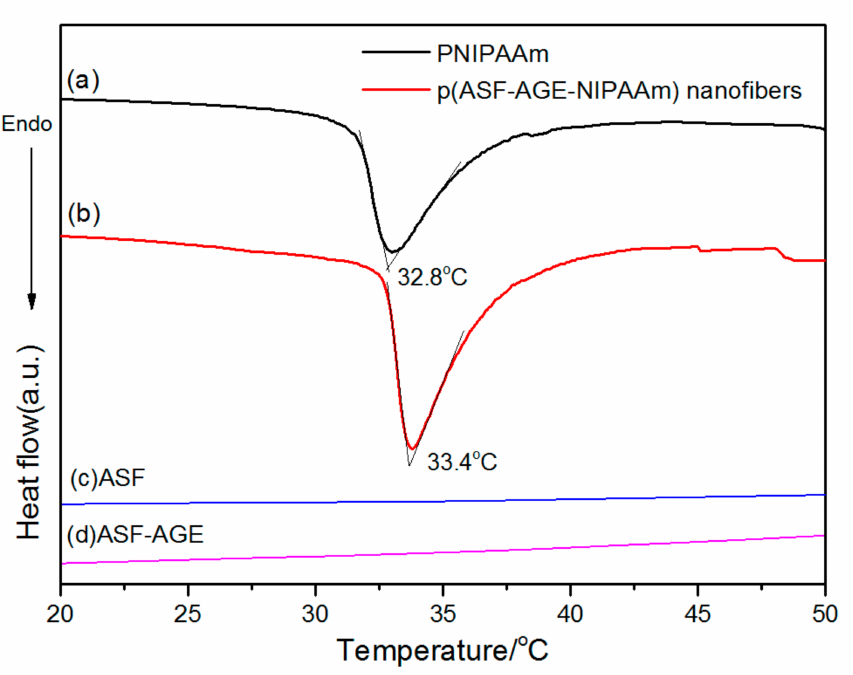
Figure 8. DSC curves for ( a ) PNIPAAm, ( b ) p (ASF-AGE-NIPAAm) hydrogel nanofibers, ( c ) ASF and ( d )